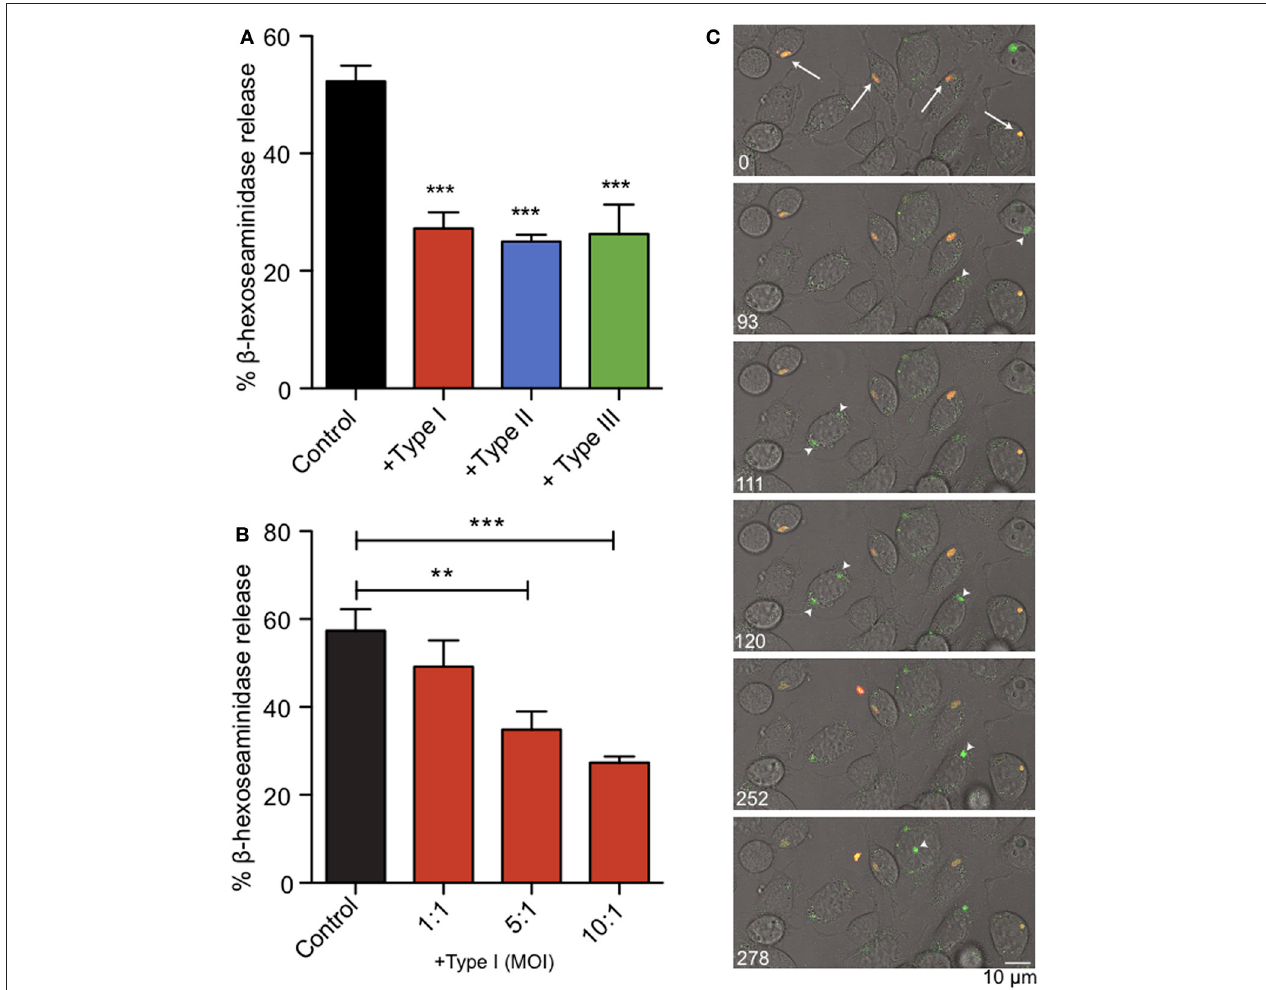
representative experiment showing inhibition of degranulation increases with increasing MOI. (C) Individual frames taken from live fluorescence confocal microscopy of degranulation events monitored by FITC-dextran bursts (green) in RBL cells infected with RH-tomato tachyzoites (red) and uninfected RBL cells in the same field. White arrows (timepoint 0) indicate infected cells. Arrowheads highlight degranulation events in uninfected cells (frames taken from supporting movie